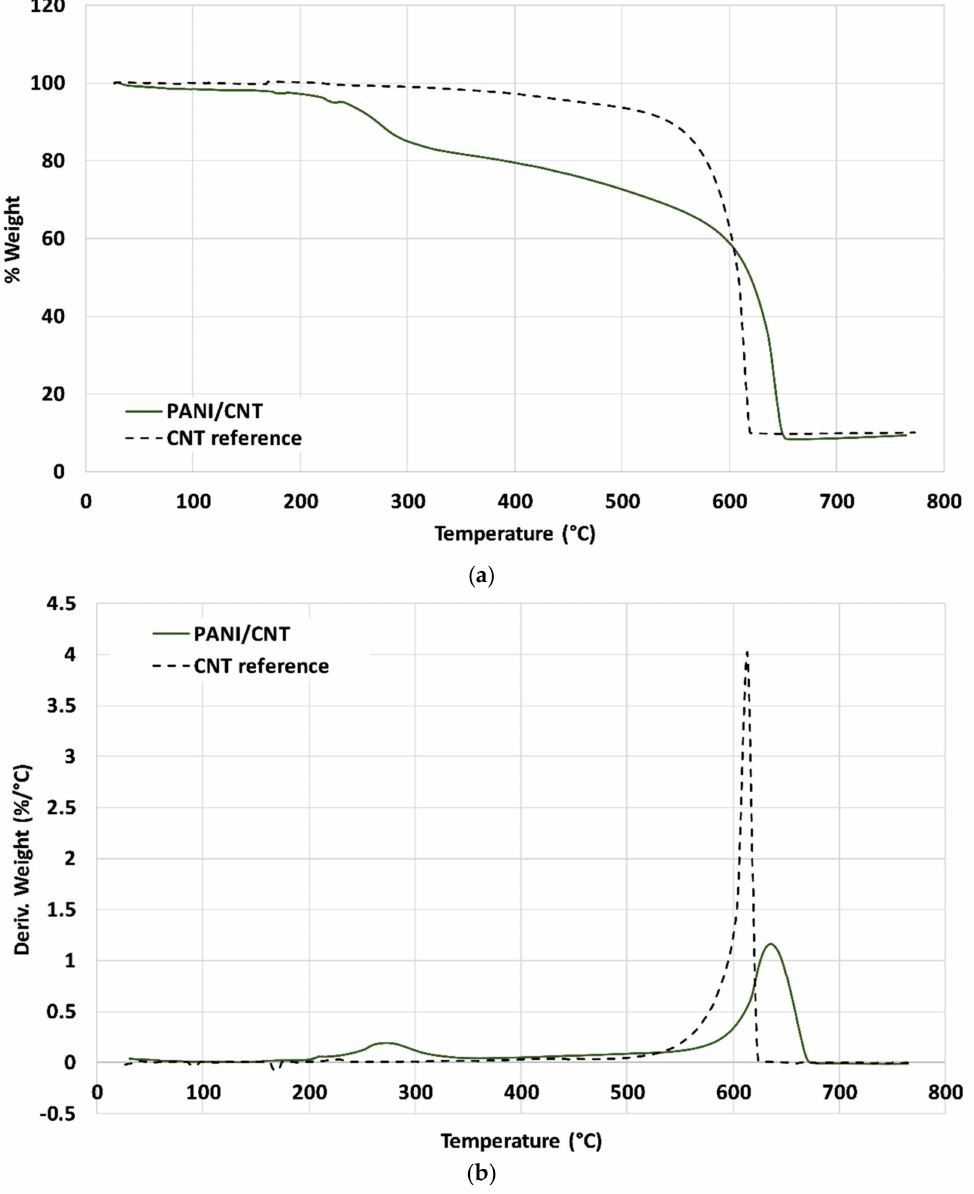
Figure 3. ( a ) Thermal gravimetric analyzer (TGA) thermograms of neat CNT and PANI grafted CNT Bucky paper. ( b ) derivative thermal gravimetric (DTG) thermograms of neat CNT and PANI grafted CNT Bucky